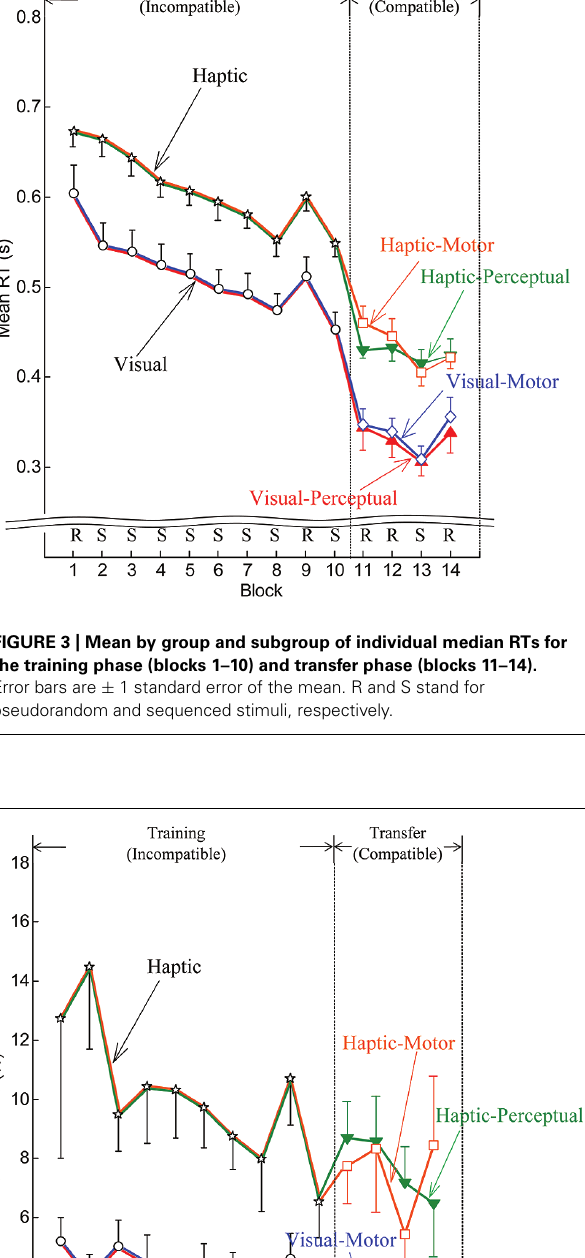
Figure 6A . Each Training Error Score quantifies the increase